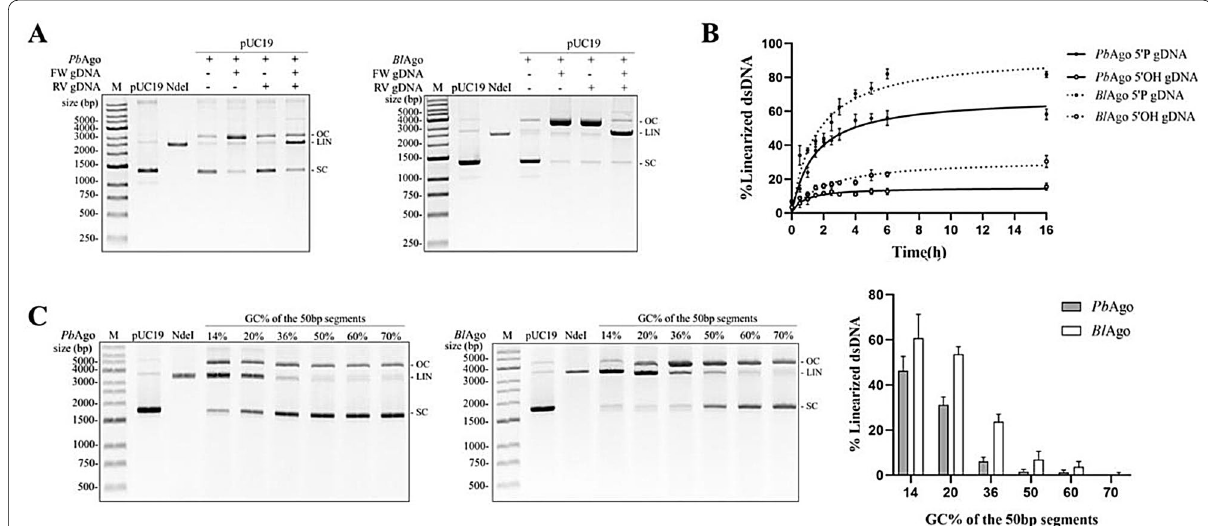
Fig. 4 Cleavage of pUC19 by Pb Ago and Bl Ago. a Pb Ago cleaves pUC19 at 37 °C guided by a pair of 5 ′ -P gDNAs. Bl Ago cleaves pUC19 at 65 °C guided by a pair of 5 ′ -P gDNAs. n Kinetic performance of Pb Ago- and Bl Ago-cleaving pUC19. c Effect of GC content of 50 bp plasmid target fragment on Pb Ago and Bl Ago cleavage activity. FW/RV gDNA, forward and reverse gDNAs; M, molecular weight marker; OC, open circular plasmid; Lin, linearized plasmid; SC, supercoiled